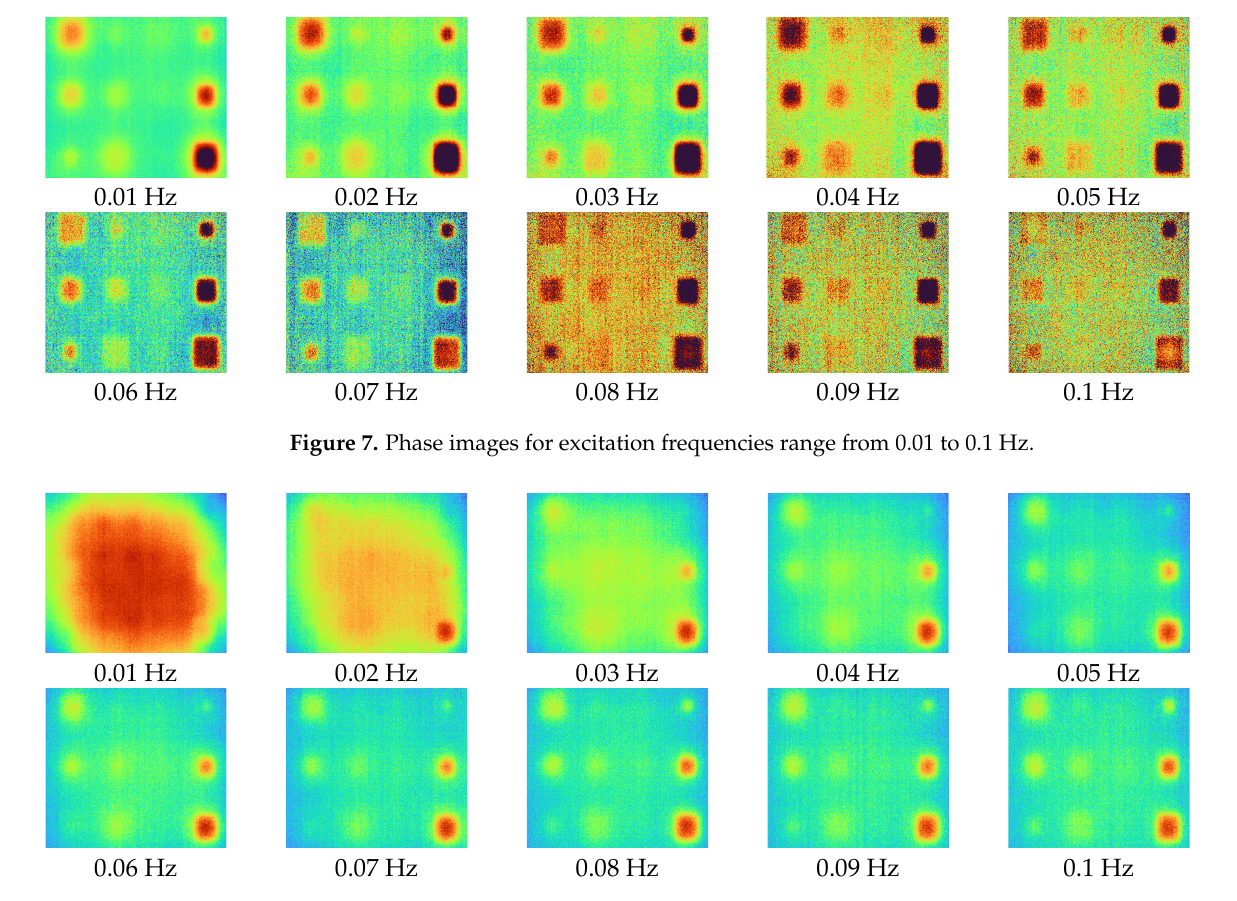
7 of 13 Figure 6. Schematic diagram of the LIT experimental setup for measuring the thermal response of